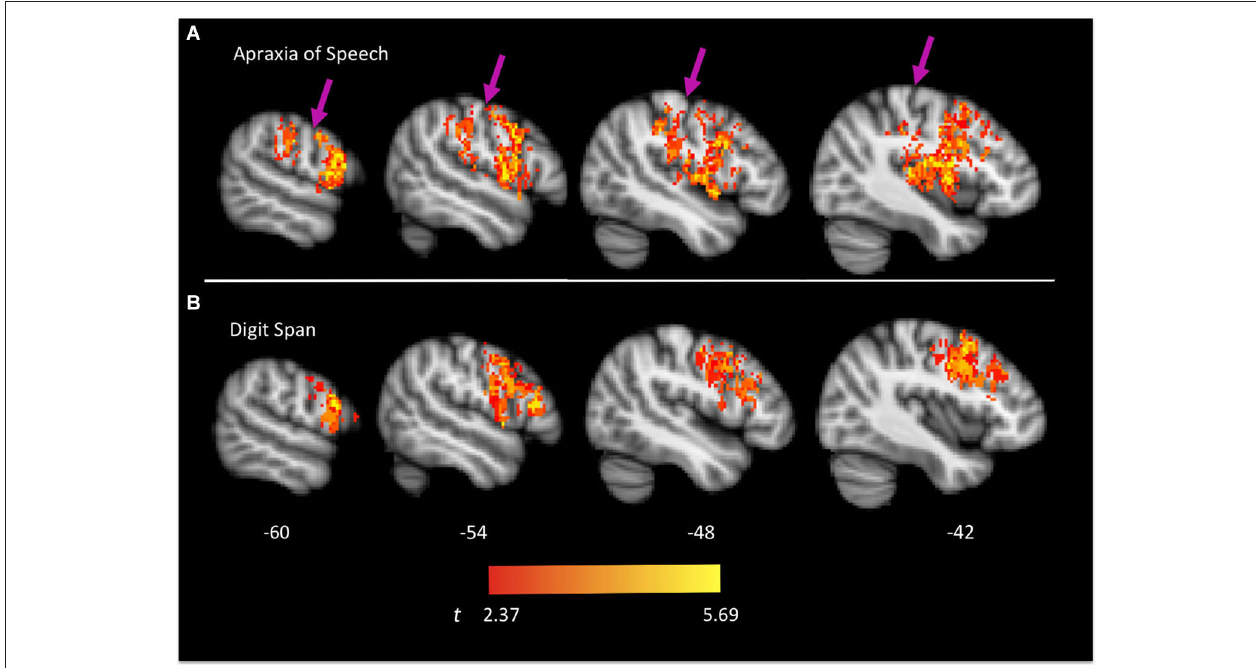
FIGURE 2 | Group map of voxels significantly related to apraxia of speech (A) and impaired digit span performance (B) . Left hemisphere is shown. Arrows indicate the central sulcus.